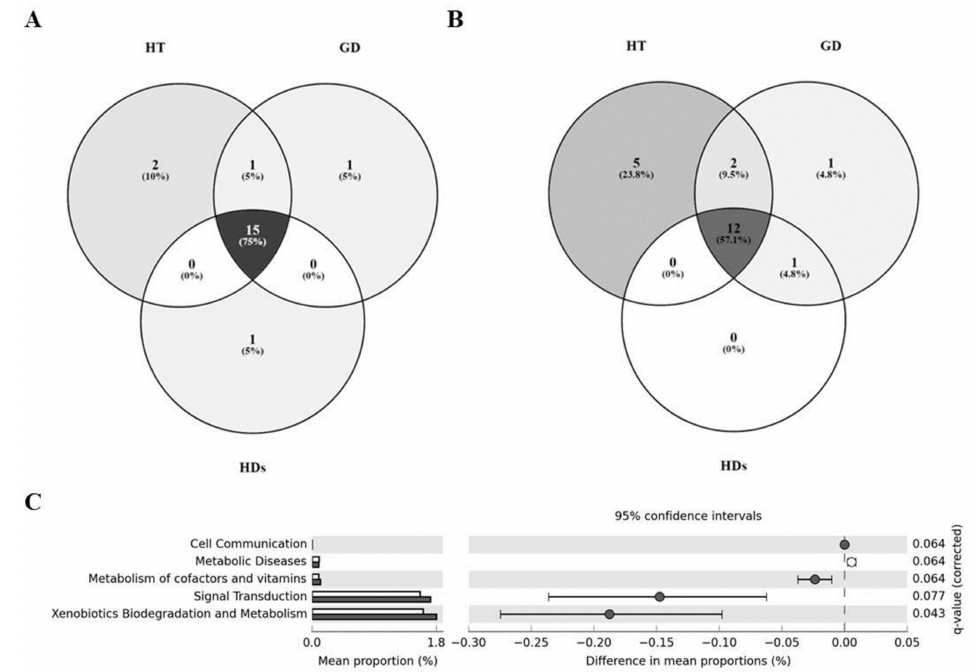
Figure 3. ( A ) Venn diagram of the core microbiome from the study groups at the family level. ( B ) Venn diagram of the core microbiome from the study groups at the genus level. ( C ) Significant di ff erences in predicted functional composition at level 2 of Kyoto Encyclopedia of Genes and Genomes (KEGG) Pathways of the gut microbiota among HDs (white) and GD patients (dark grey). Only functional capacities with p < 0.1 are shown; q = p -value